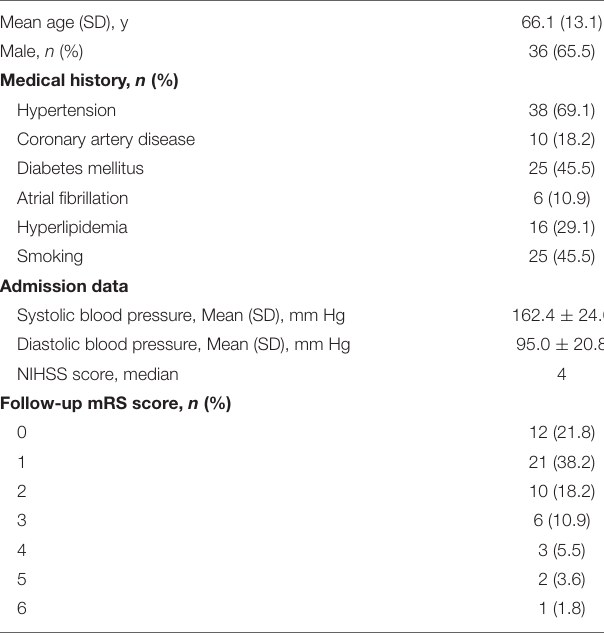
TABLE 1 | Baseline clinical characteristics of 55 patients with AIS ( n =